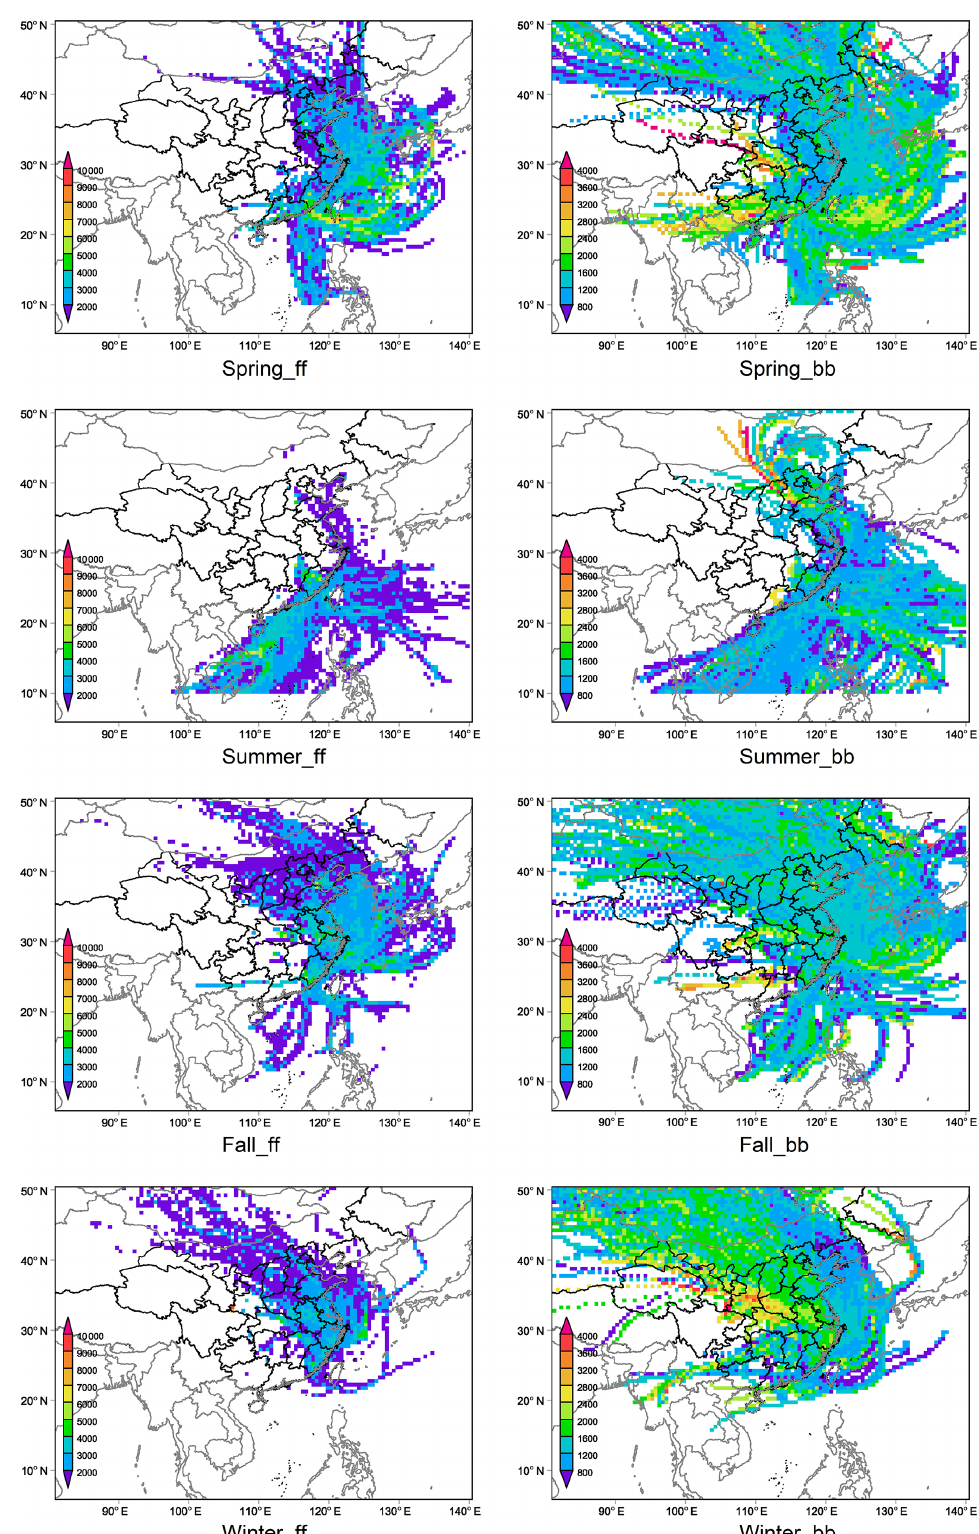
Figure 9. CWT maps for BC ff and BC bb in Xiamen for different seasons in